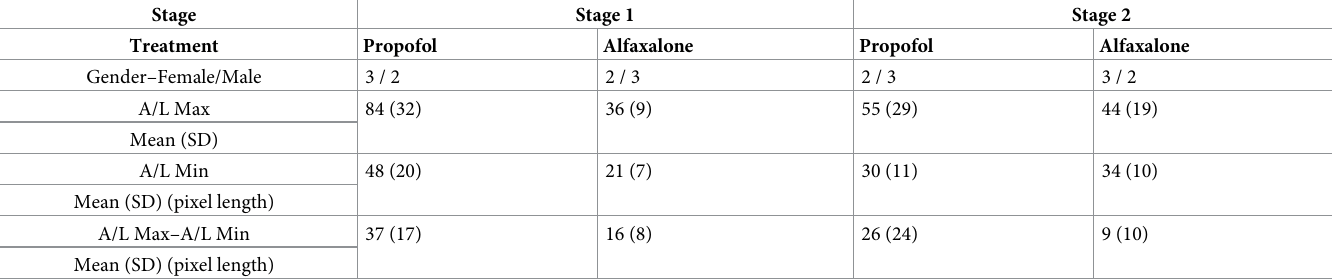
Table 2. Summary of study design and study outcome of A/L values by study stage and anesthesia agent group.